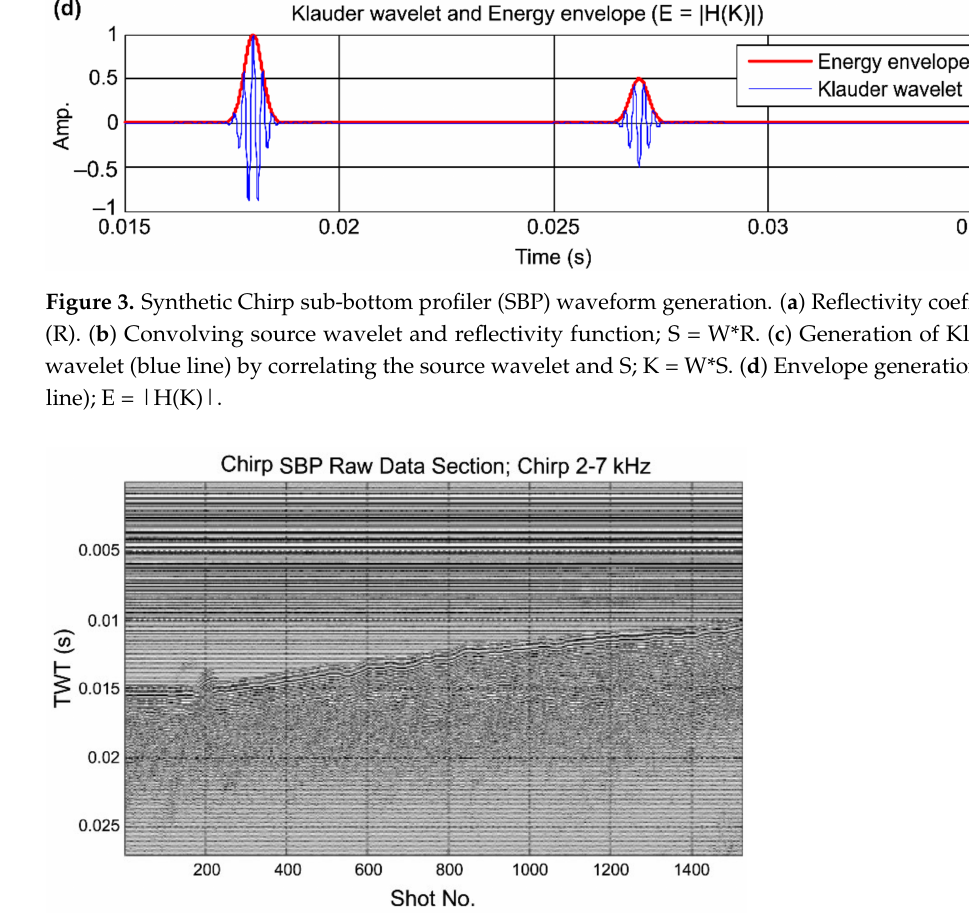
Figure 4. Chirp sub-bottom profiler (SBP) raw data section. TWT = two-way travel time.